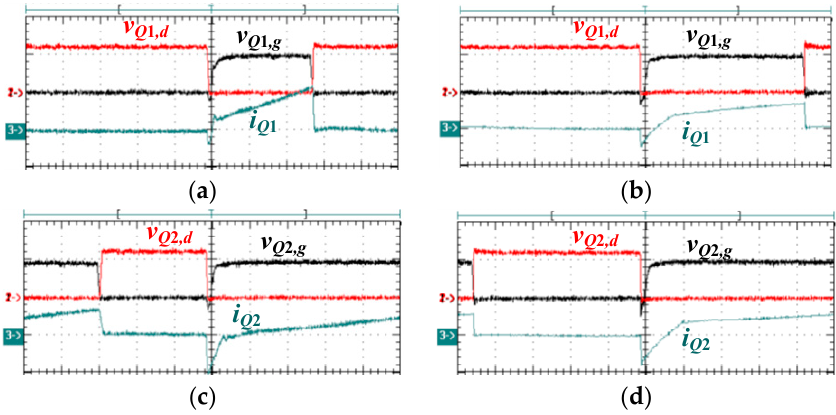
Figure 11. Measured secondary side currents at ( a ) 20% load [ i D 1 , i D 2 , i Lo 1 , i Lo 2 , i Lo 1 + i Lo 2 : 10 A/div; time: